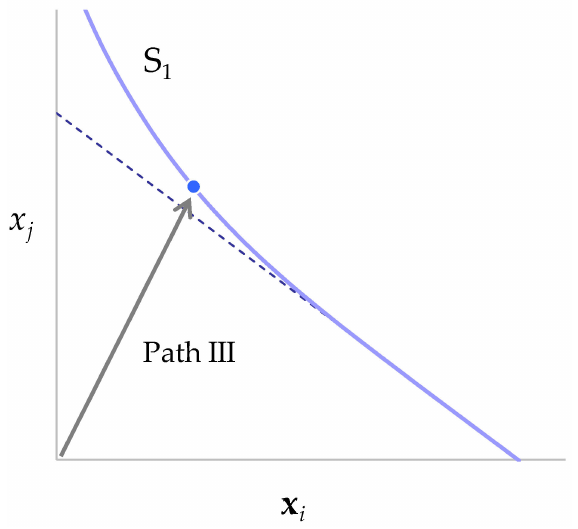
Figure A9. Case with electricity